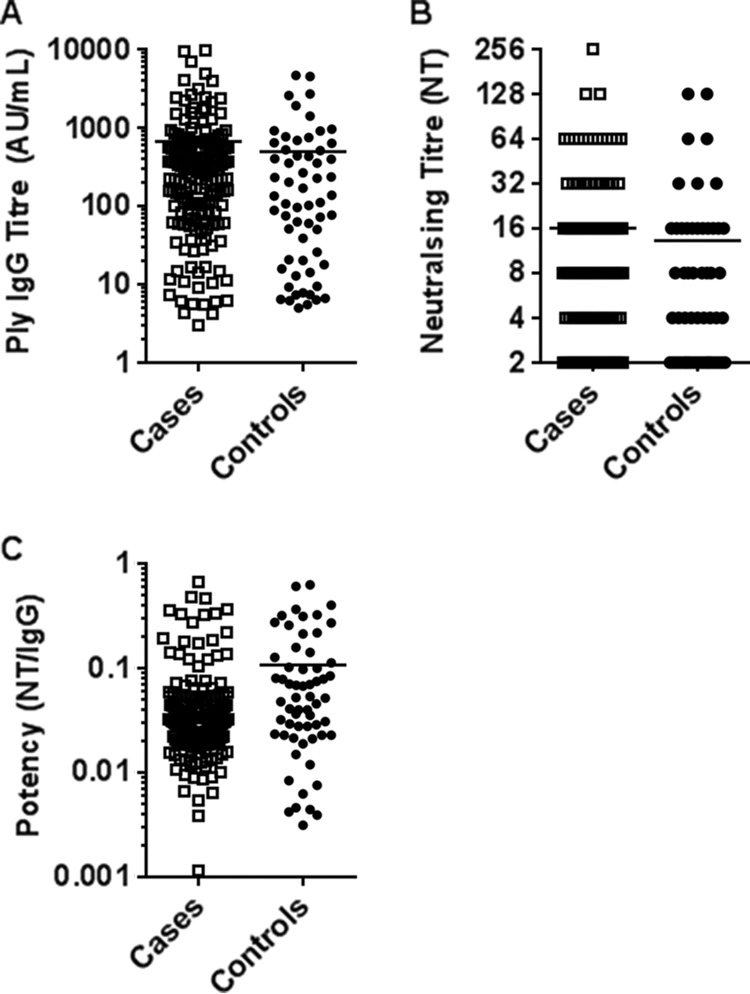
Pneumolysin IgG antibody titers (A), neutralizing titers (NTs) (B), and antibody potencies (C) in sera from otitis-prone (open squares) and healthy (closed circles) children. Data are presented for each individual child, with the horizontal bars depicting the means. Statistical analysis was conducted on the geometric mean of log-transformed data, correcting for age, gender, and day care attendance. AU, arbitrary units; Ig, immunoglobulin.